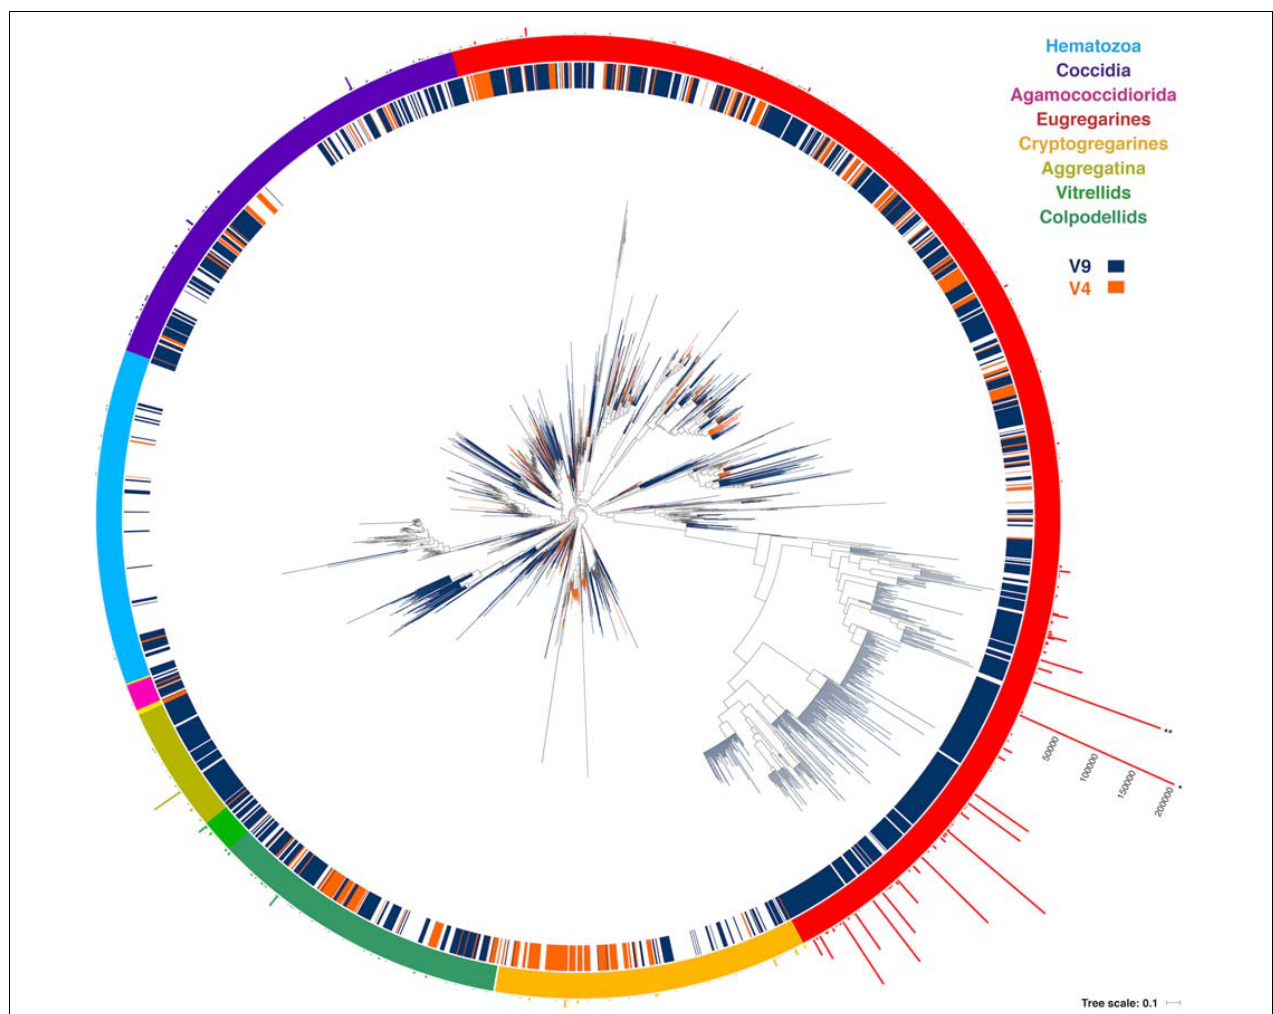
FIGURE 4 | Round tree showing the placement of the short reads using the Evolutionary Placement Algorithm in RAxML (EPA-RAxML) on the reference tree. The colors of the leaves and the inner crown surrounding the tree indicate the 18S rRNA region of the corresponding OTUs (V4 or V9). The outer crown indicates the number of reads per